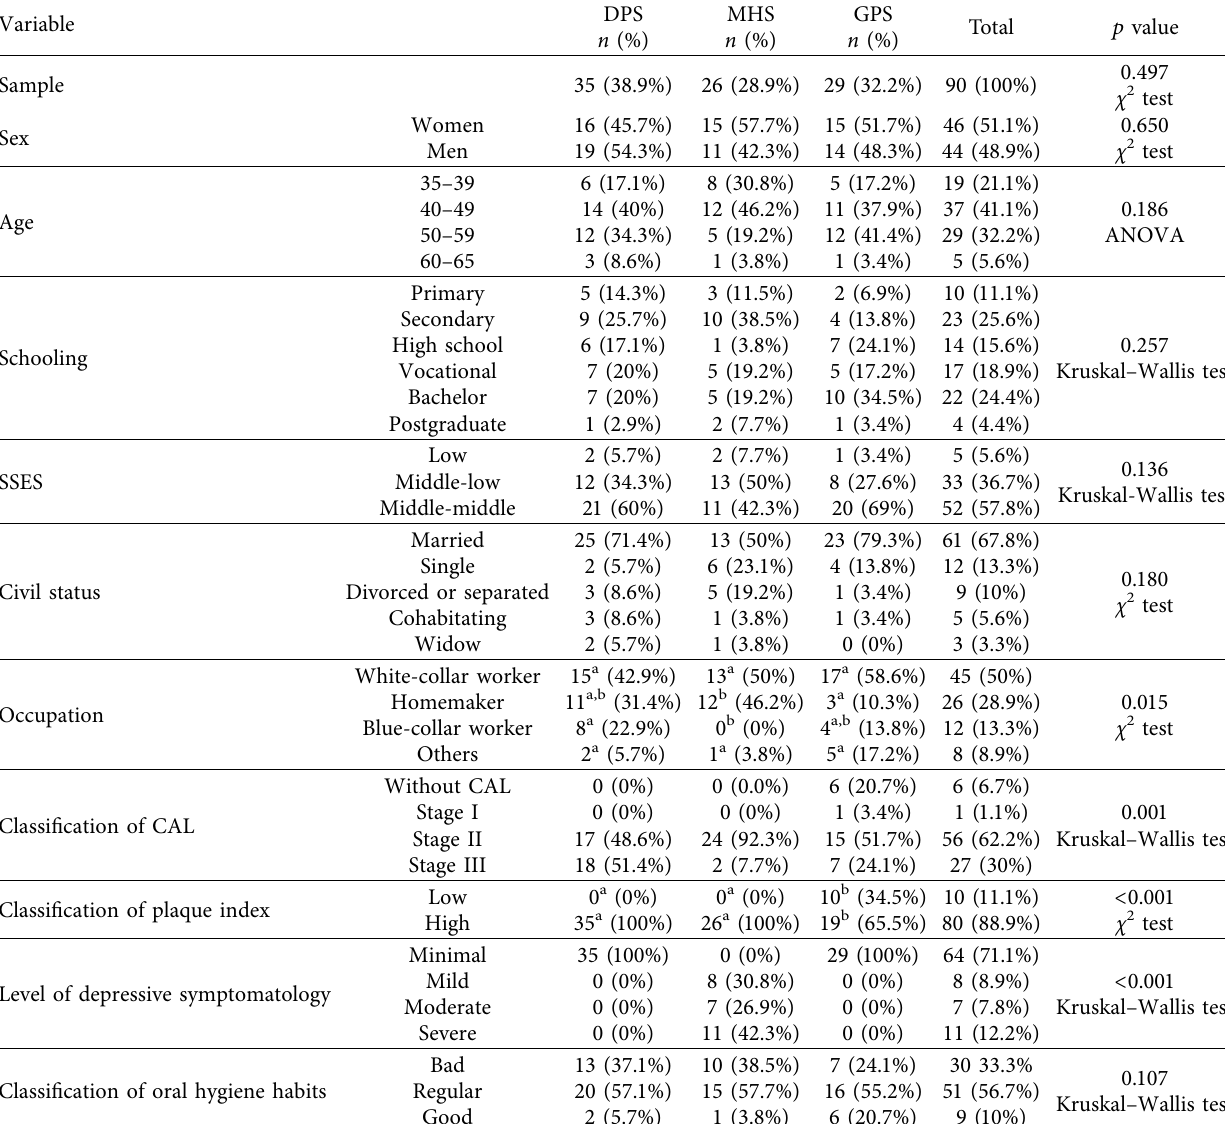
Table 3: Sociodemographic and clinical variables and statistical comparison among the 3